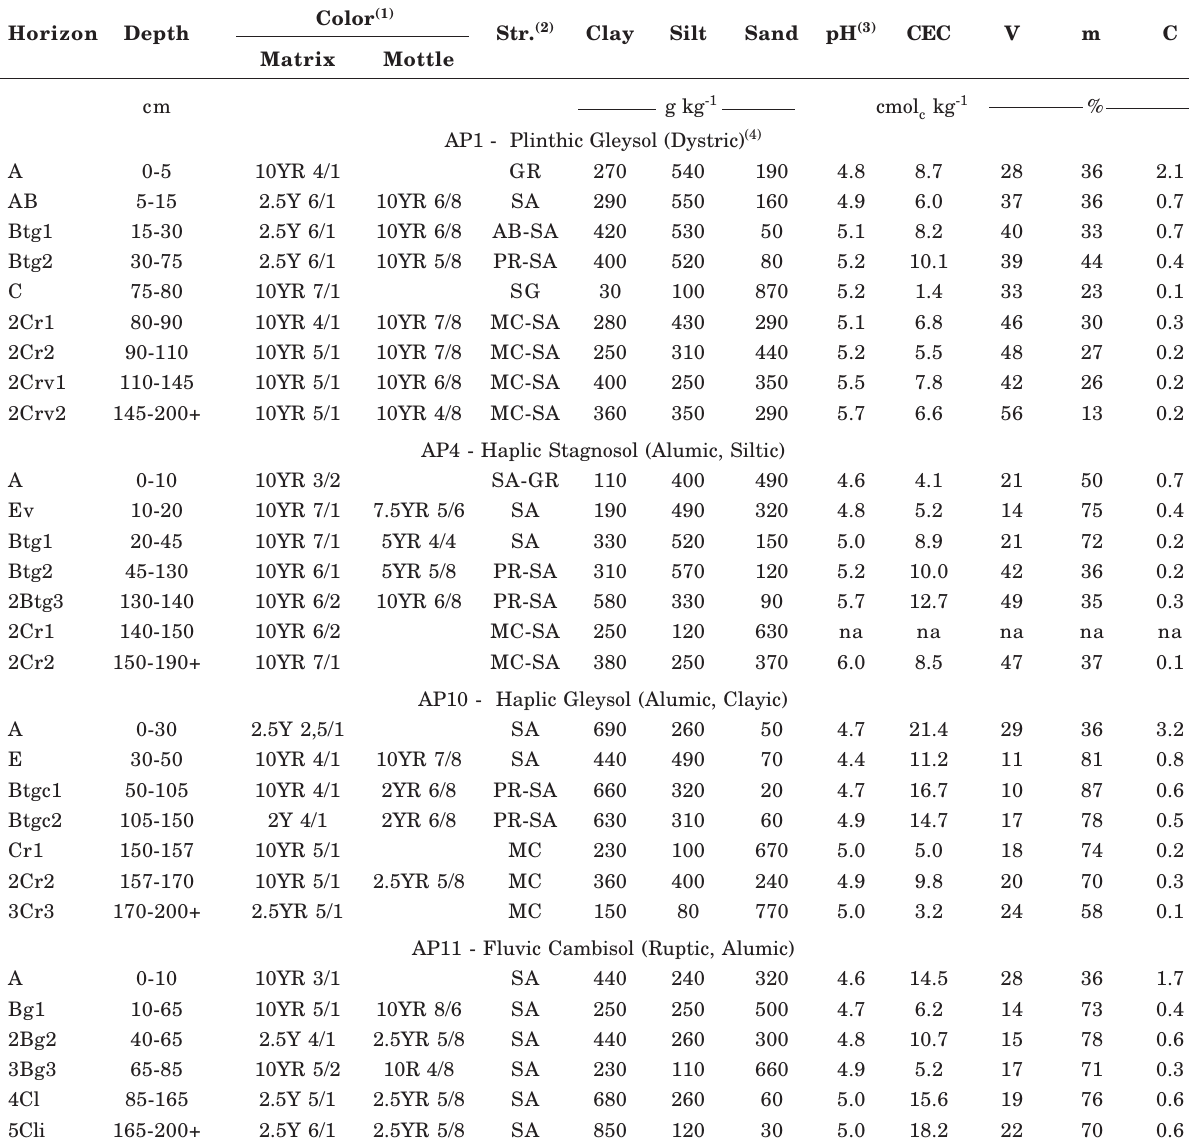
Table 1. Particle size and main morphological and chemical properties of the profiles